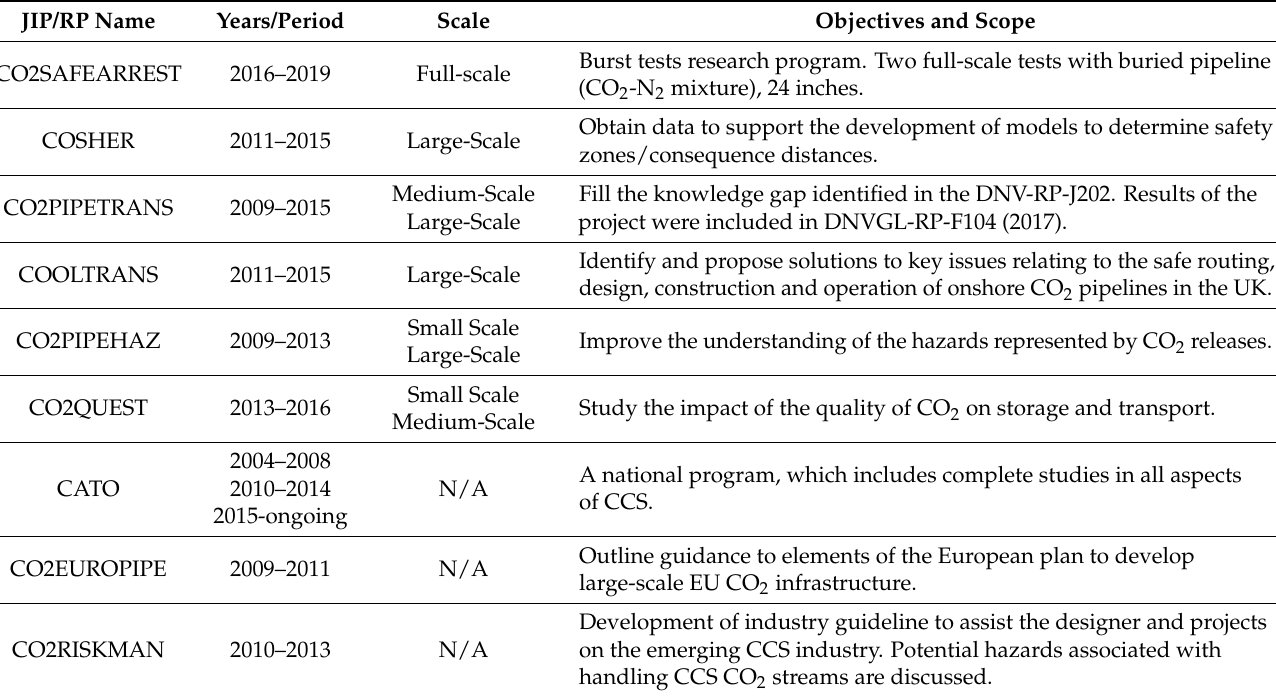
Table 1. Relevant CO 2 pipeline related JIPs and RPs programs during the